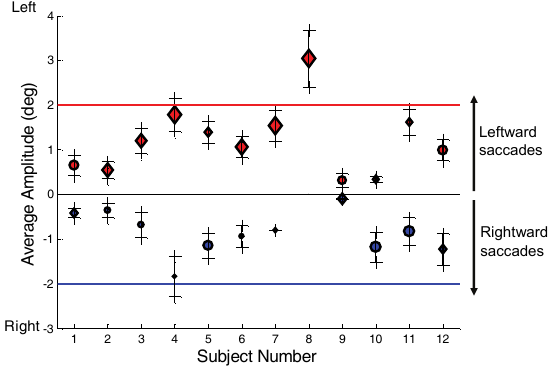
Figure 8 The average position eye closest to the target following an initial asymmetry-inducing saccade; that is, the average position of the right eye (blue) after a leftward saccade and the average position of the left eye (red) after a rightward saccade. The red and blue lines indicate the final target position for the left and right eyes, respectively. The size of the diamond provides an approximate indicator of the percentage of saccades (out of the total number of initial saccades) that contributed to the average. Three subjects (4, 7, and 11) have initial saccades that place the preferred eye within half a degree of the